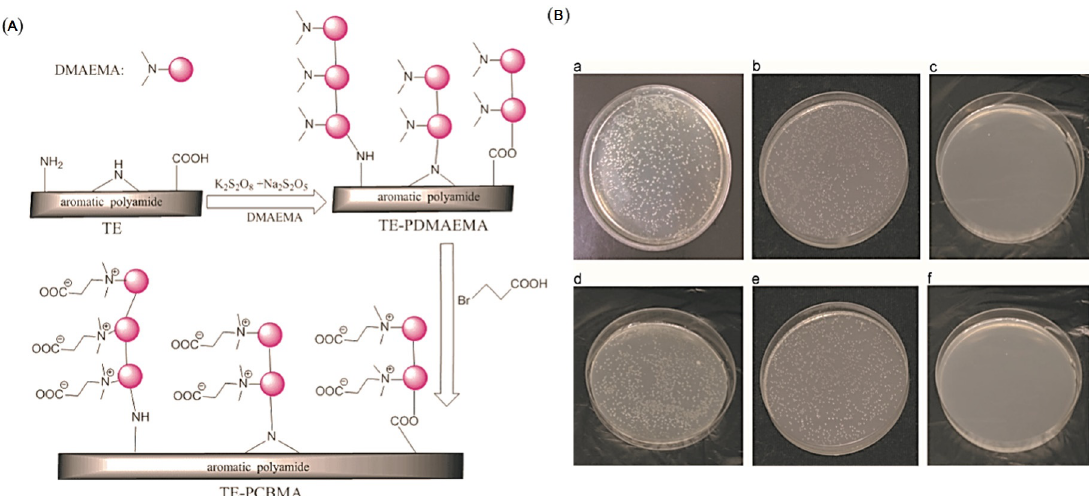
Figure 3. ( a ) The schematic of the membrane modification process. ( b ) a, b, and c: The B. subtilis colonies after contacted with TE, TE–PDMAEMA10 and TE–PCBMA membrane, respectively. d e, respectively. (contact time: 2 h) [86]. (Copyright (2015) with permission from Elsevier